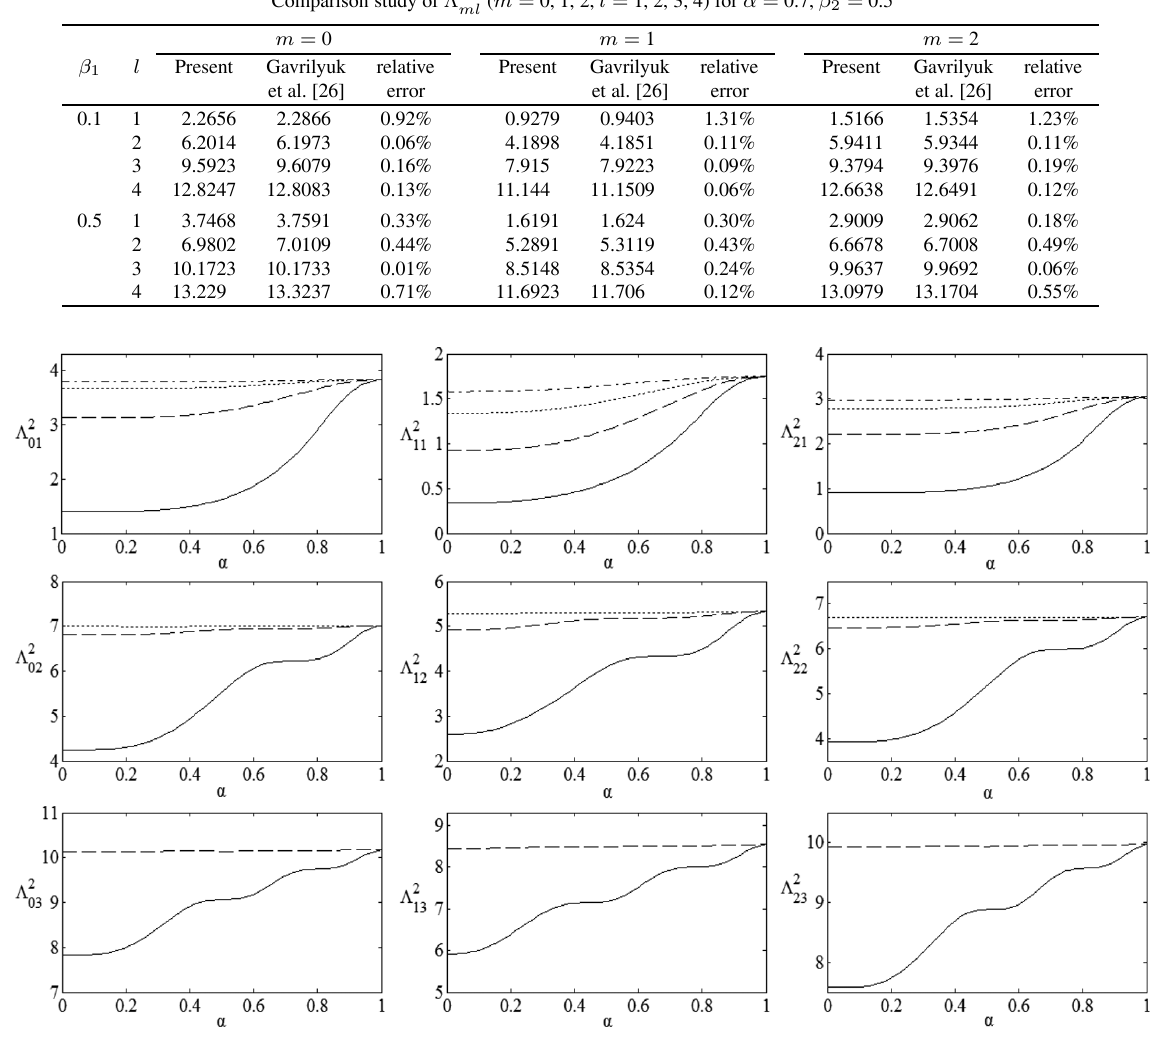
Fig. 3. Non-dimensional frequency parameters Λ 2 ml ( m = 0, 1, 2, l = 1, 2, 3) versus α for β = 1 and four different β 1 (—— β 1 = 0.2, – – – β 1 = 0.4, ······ β 1 = 0.6, – · – β 1 =